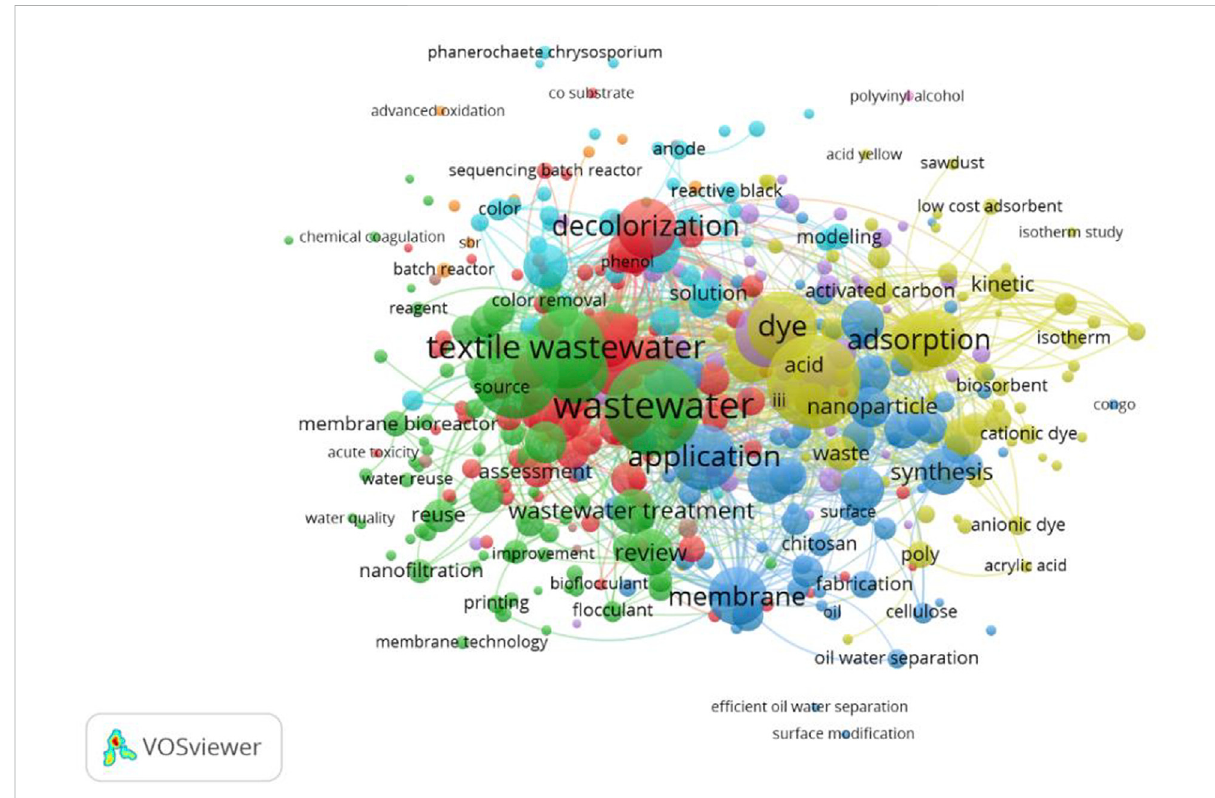
FIGURE 10 Terms co-occurrence map. Wastewater and textile wastewater were linked to most of the